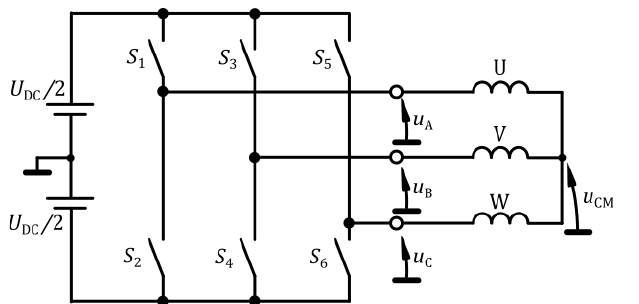
Figure 3. Schematic diagram of a two-level three-phase frequency converter with specified common-mode voltage u CM .